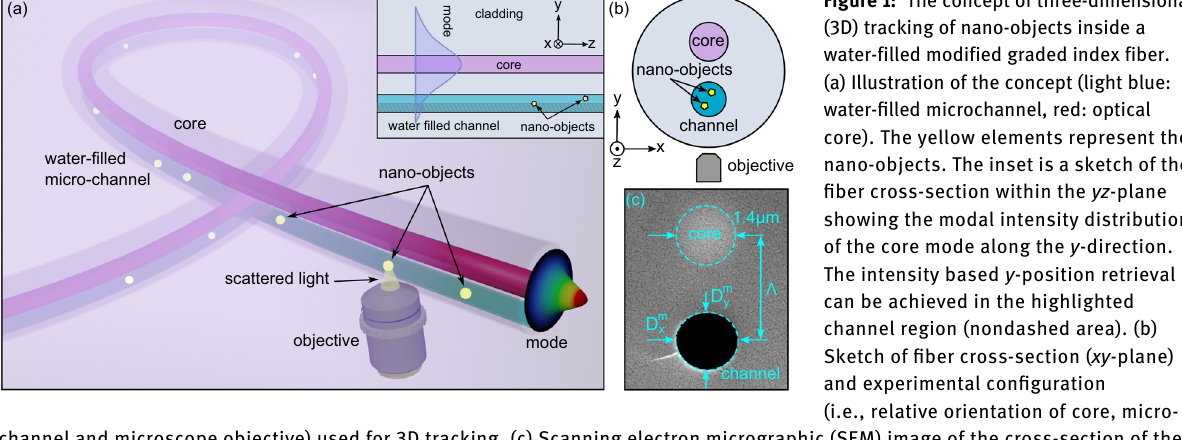
Figure 1: The concept of three-dimensional (3D) tracking of nano-objects inside a water-filled modified graded index fiber. (a) Illustration of the concept (light blue: water- fi lled microchannel, red: optical core). The yellow elements represent the nano-objects. The inset is a sketch of the fi ber cross-section within the yz -plane showing the modal intensity distribution of the core mode along the y -direction.